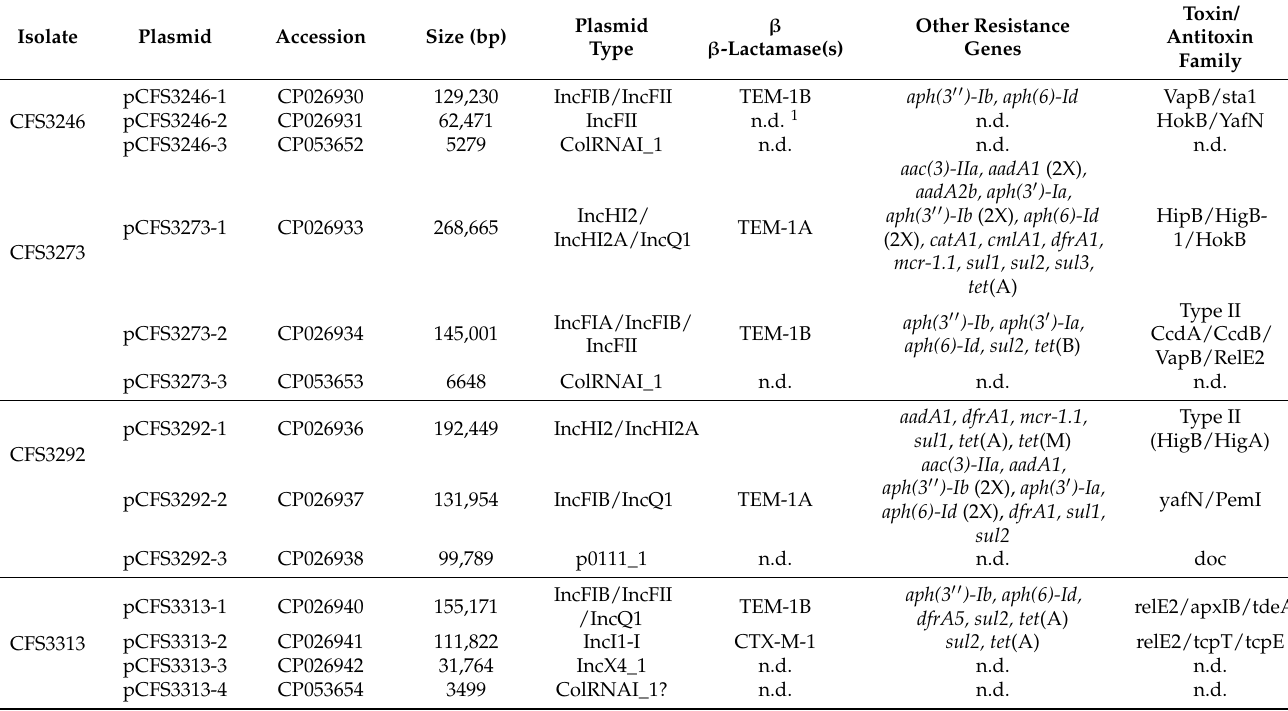
Table 2. Relevant features of all thirteen plasmids. The nucleotide sequence lengths are provided along with the Inc- and pMLST-types for plasmids and the associated toxin-antitoxin (TA) systems encoded by the plasmids.